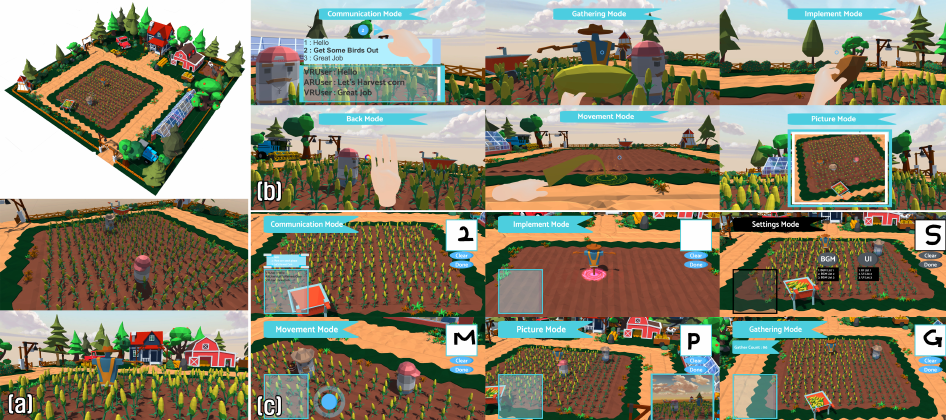
Figure 6. Results of creating an asymmetric experience environment with a virtual farm background: ( a ) Results of creating the virtual environment and the experience process, ( b ) VR user, ( c ) AR